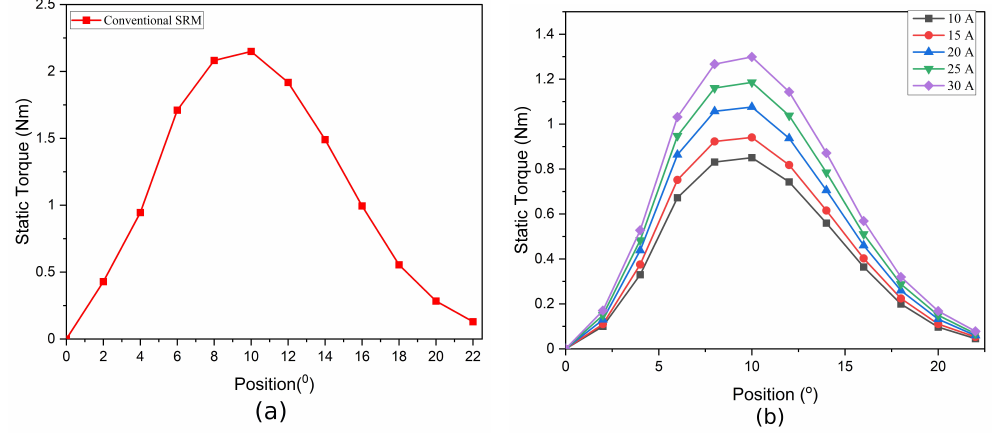
Figure 7. Static torque characteristics: ( a ) conventional SRM at rated current 15 A. ( b ) HESRM under various currents with respect to the DC field